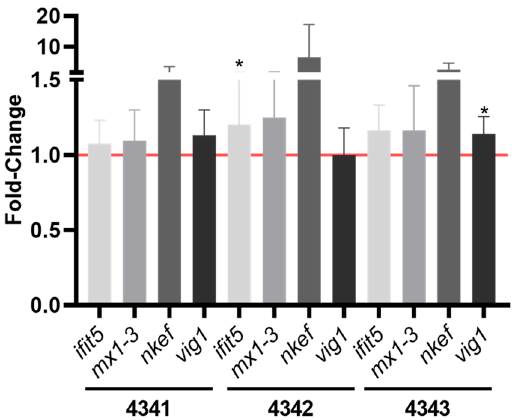
Figure 3. Antiviral immunomodulation of the peptides in rainbow trout RBCs. Antiviral gene ( ifit5 , mx1-3 , nkef , and vig1 ) expression quantified by RT-qPCR in RBCs at 6 h post-treatment (hpt) with 50 µM of each peptide. Gene expression was normalized against ef1 α and relativized to control cells (RBCs untreated) (red line). Data represent the mean ± standard deviation (SD), n = 4. Mann–Whitney test was performed (* p < 0.05).